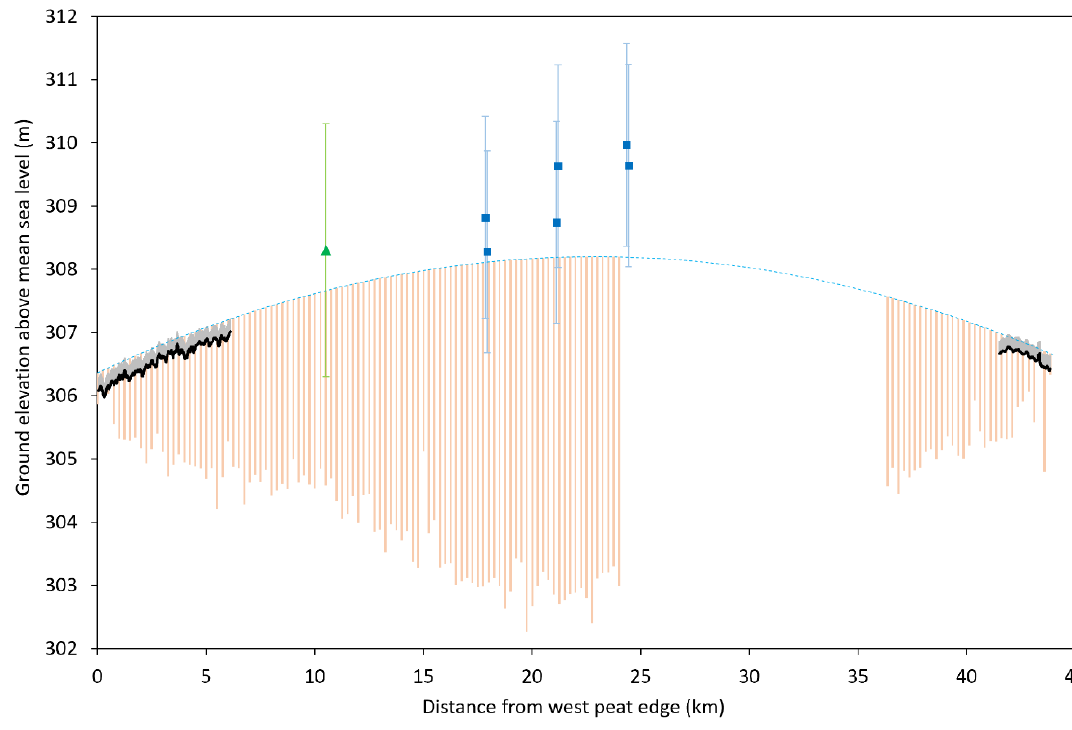
Figure 9. Plot of peat depths (orange vertical bars), ground elevations from ICESat ( (cid:78) ), ICESat-2 ( (cid:4) ), UAV LiDAR 100m moving average (black line with grey error bars) and parabolic fit (blue dashed line) with a peak at 308.2 m, along the Figure 2 Epena–Ekolongouma path.